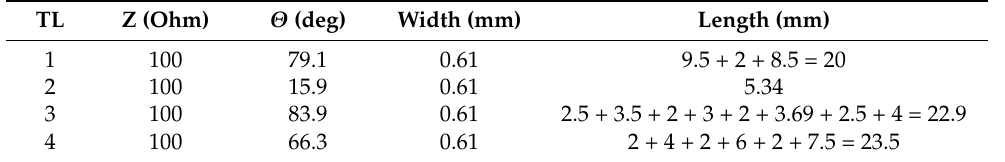
Figure 10. ( a ) The simulated current distribution on the DMN at the center frequency; and ( b ) the layout of the DMN. layout of the DMN. Table 1. Design parameters of the DMN. Table 1. Design parameters of the DMN.